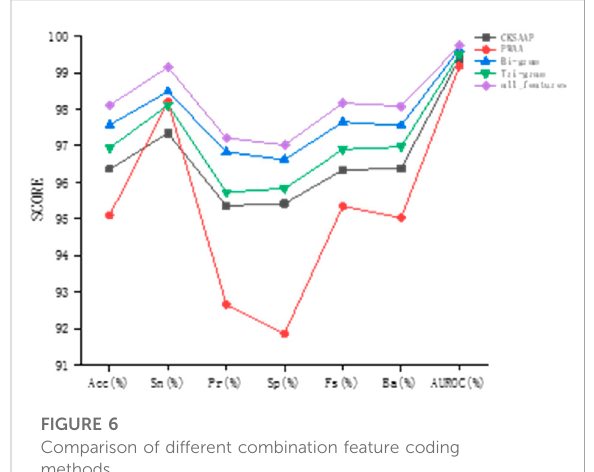
FIGURE 6 Comparison of different combination feature coding